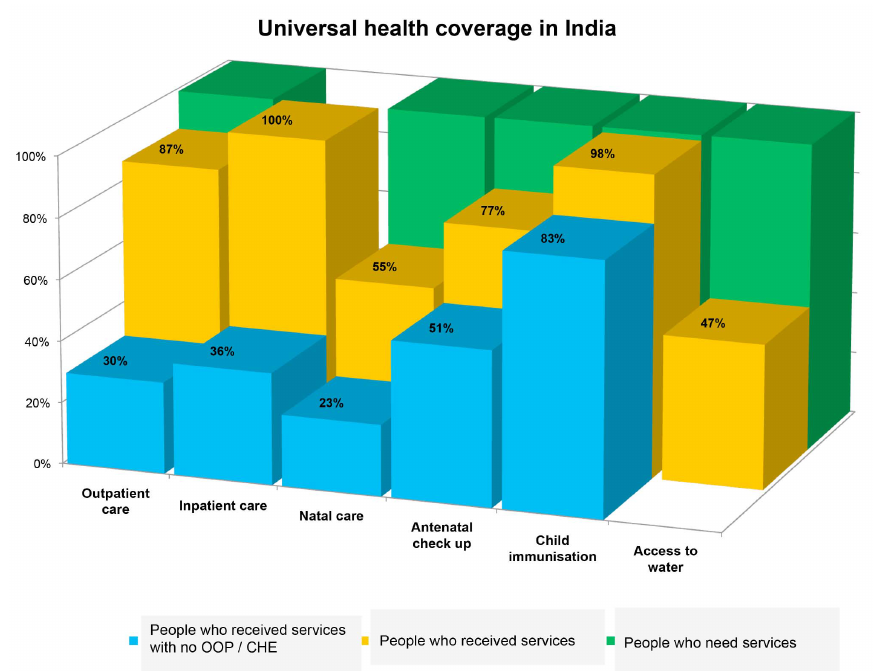
Figure 2. Universal health coverage for selected health services in India in 2004. Source: NFHS 3, DLHS 3, NSS 60th round, and Coverage evaluation Survey [8–10,15].